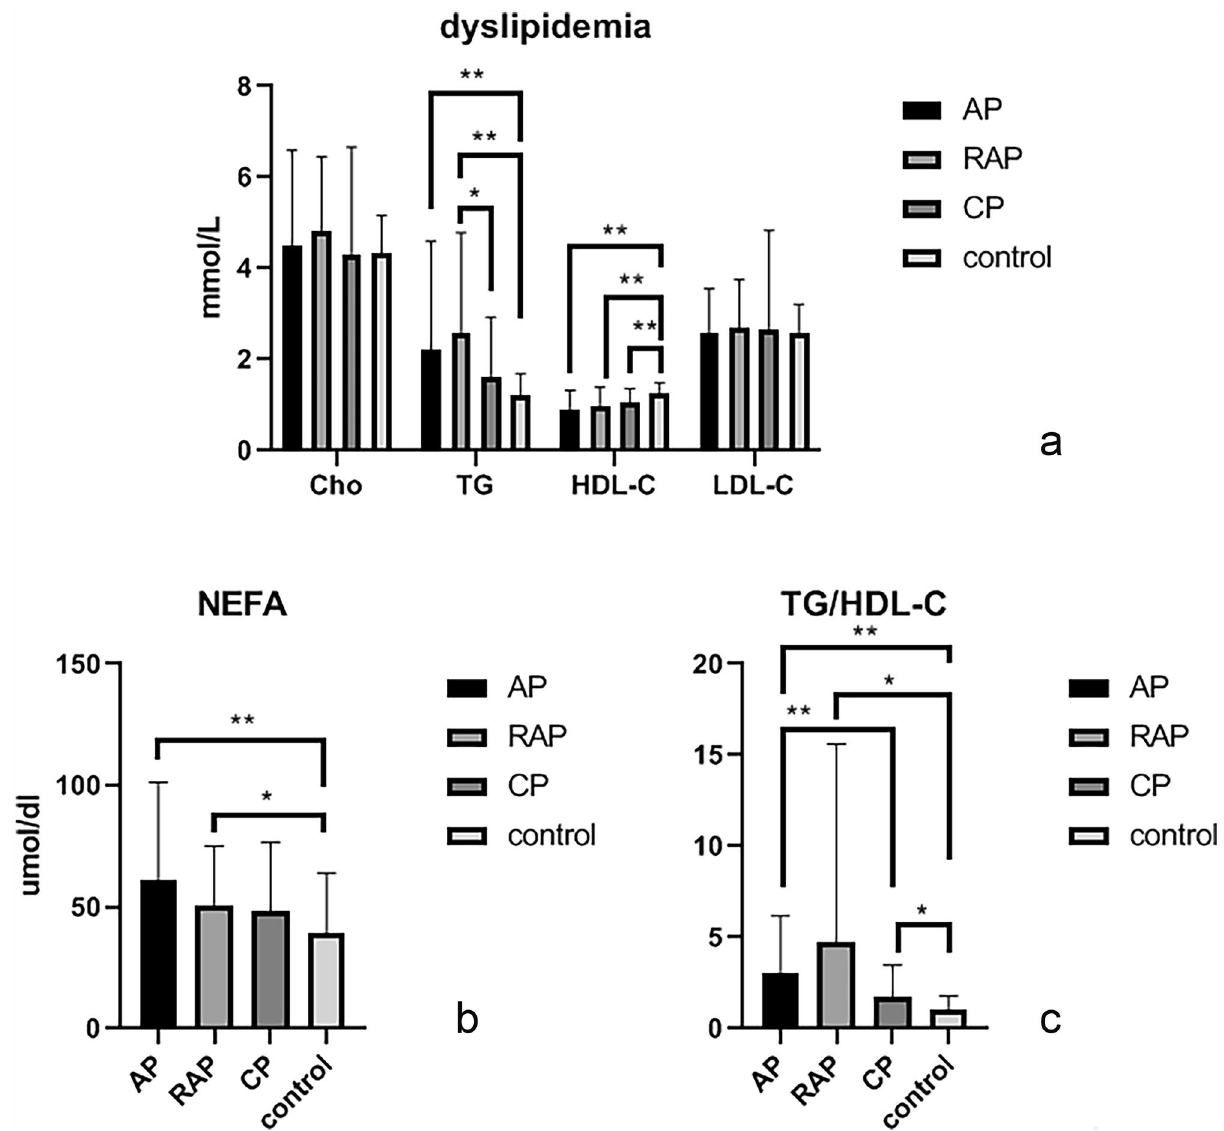
Figure 3. Dyslipidemia in different types of pancreatitis. ( a ) Dyslipidemia in different types of pancreatitis; ( b ) Free fatty acid in different types of pancreatitis; ( c ) TG/HDL-C ratio in different types of pancreatitis. *p < 0.05; **p <